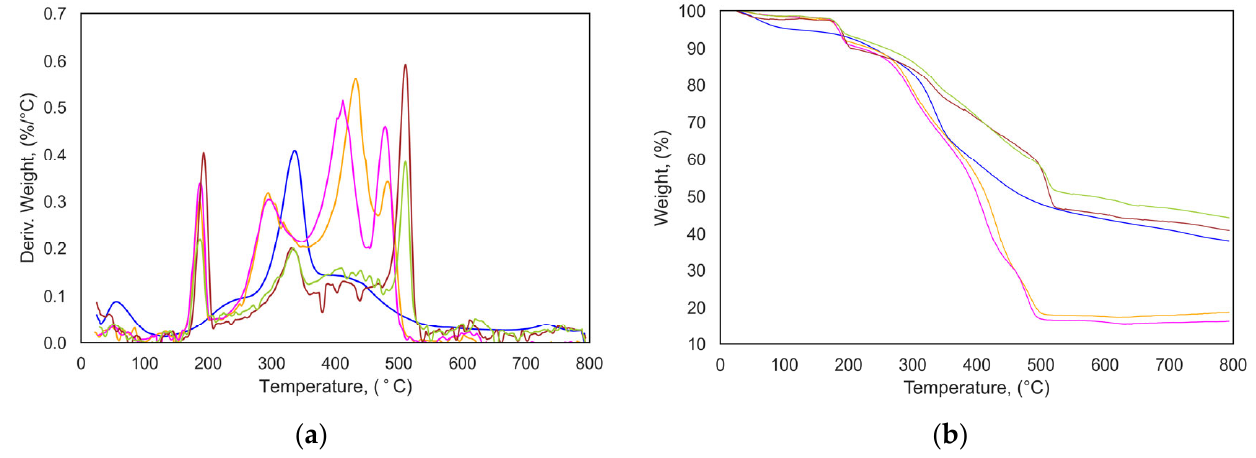
Figure 2. ( a ) dTG curves and ( b ) TGA curves of hydrochar ( ─ ) washed FS, W:B = 0; ( ─ ) UFS, W:B = 0; ( ─ ) FS, W:B = 3; ( ─ ) UFS, W:B = 3; ( ─ ) Dry S, W:B = 3. Conditions: reaction temperature of 210 °C and reaction time of 4 h.